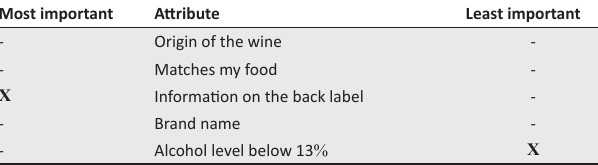
TABLE 1: An example of a completed best–worst